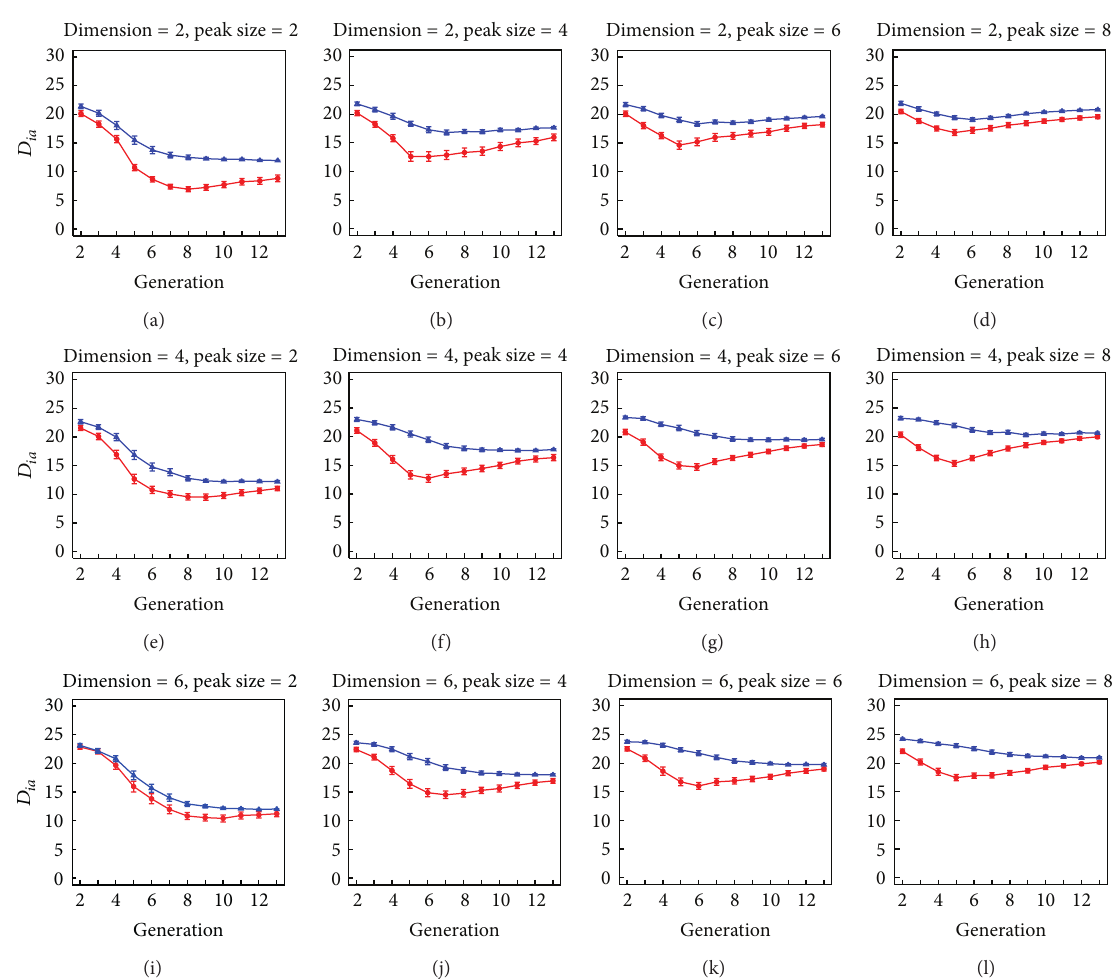
Figure10:Valueof 𝐷 𝑖𝑎 ineachgeneration.Thehorizontalaxisrepresentsthegenerationsandtheverticalaxisisthemeanof 𝐷 𝑖𝑎 after100trials. The bar represents the standard error. The results of the proposed method are depicted by the solid red lines and those of the conventional method by the dotted blue lines. The graphs in the same row correspond to landscapes of equal dimensions and those in the same column correspond to landscapes with the same number of